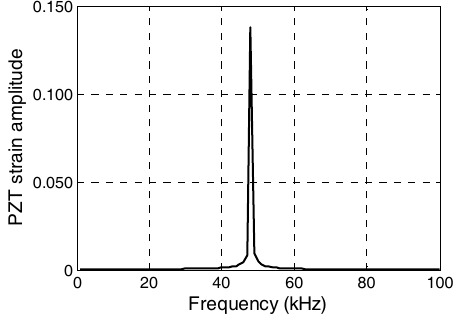
Figure 6. Frequency-PZT strain amplitude curve (1 kHz–100 kHz).